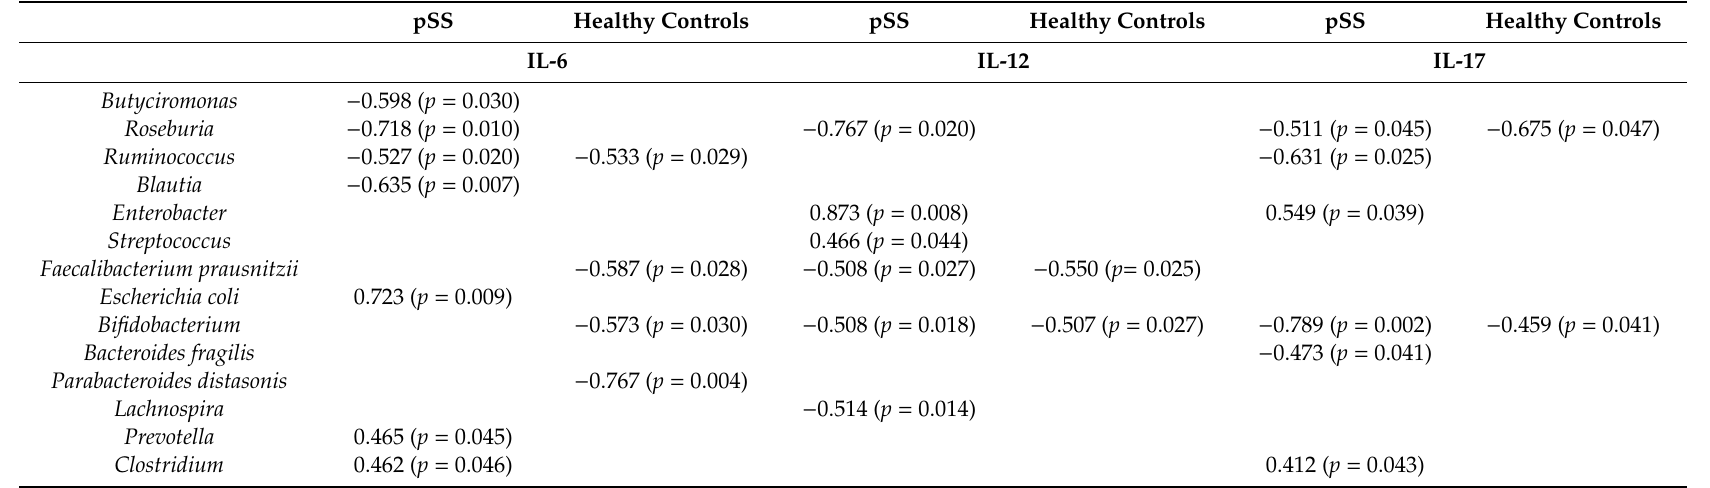
Table 2. Correlations between gut microbiota composition and serum levels of IL-6, IL-12 and IL-17 in the primary Sjögren’s syndrome (pSS) and healthy control groups.